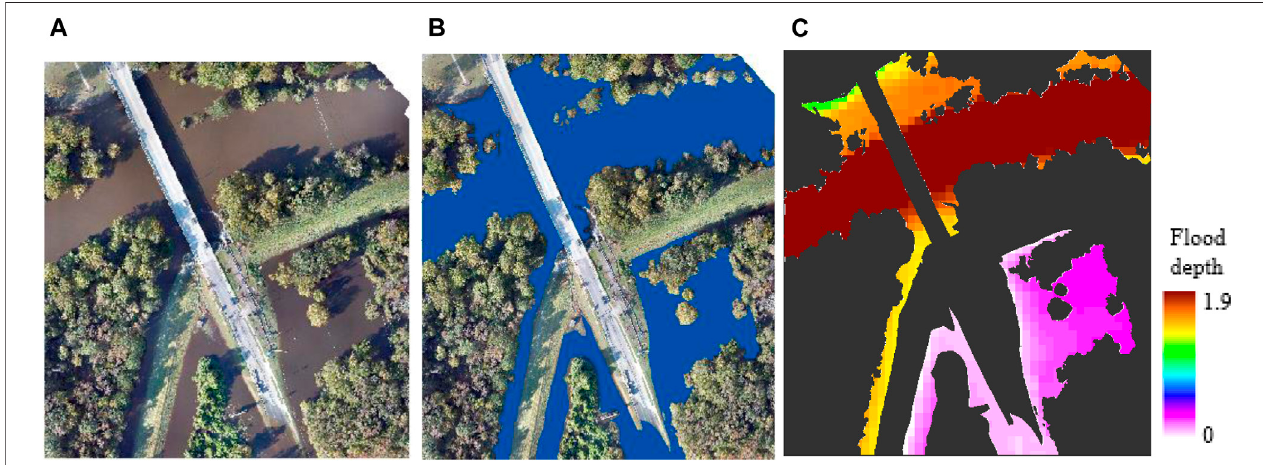
FIGURE 8 | Tar River basin morphological features measured form the LiDAR DEM. (A) River depth (hr); (B) Elevation difference (H); (C) Geomorphological fl ood index (GFI).